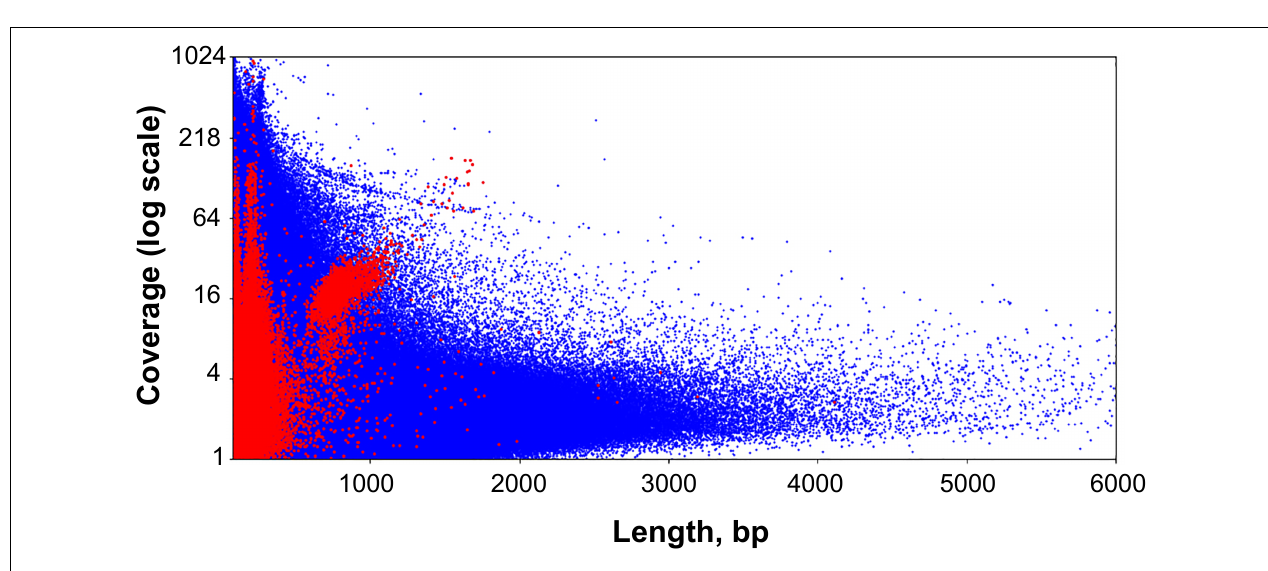
FIGURE 3 | Scatter plot of the entire set of Dicyema sp. genome assembly contigs. Blue dots are linear contigs, and red dots are circular ones.